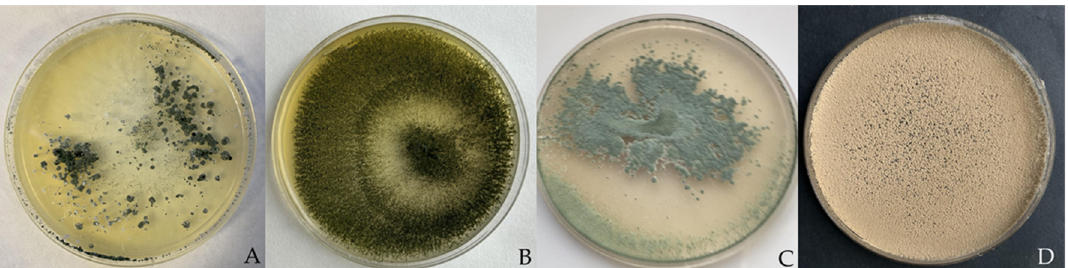
Figure 1. Fungal isolates used in this assay: ( A ) T. saturnisporum ; ( B ) T. longibrachiatum ; ( C ) T. aggressivum f. europaeum ; ( D ) P. variotii .